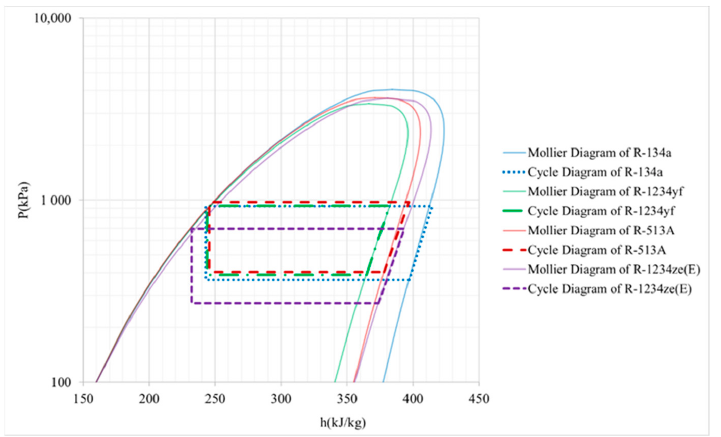
Figure 3. Mollier diagram of different refrigerants under the same evaporation and condensation conditions .